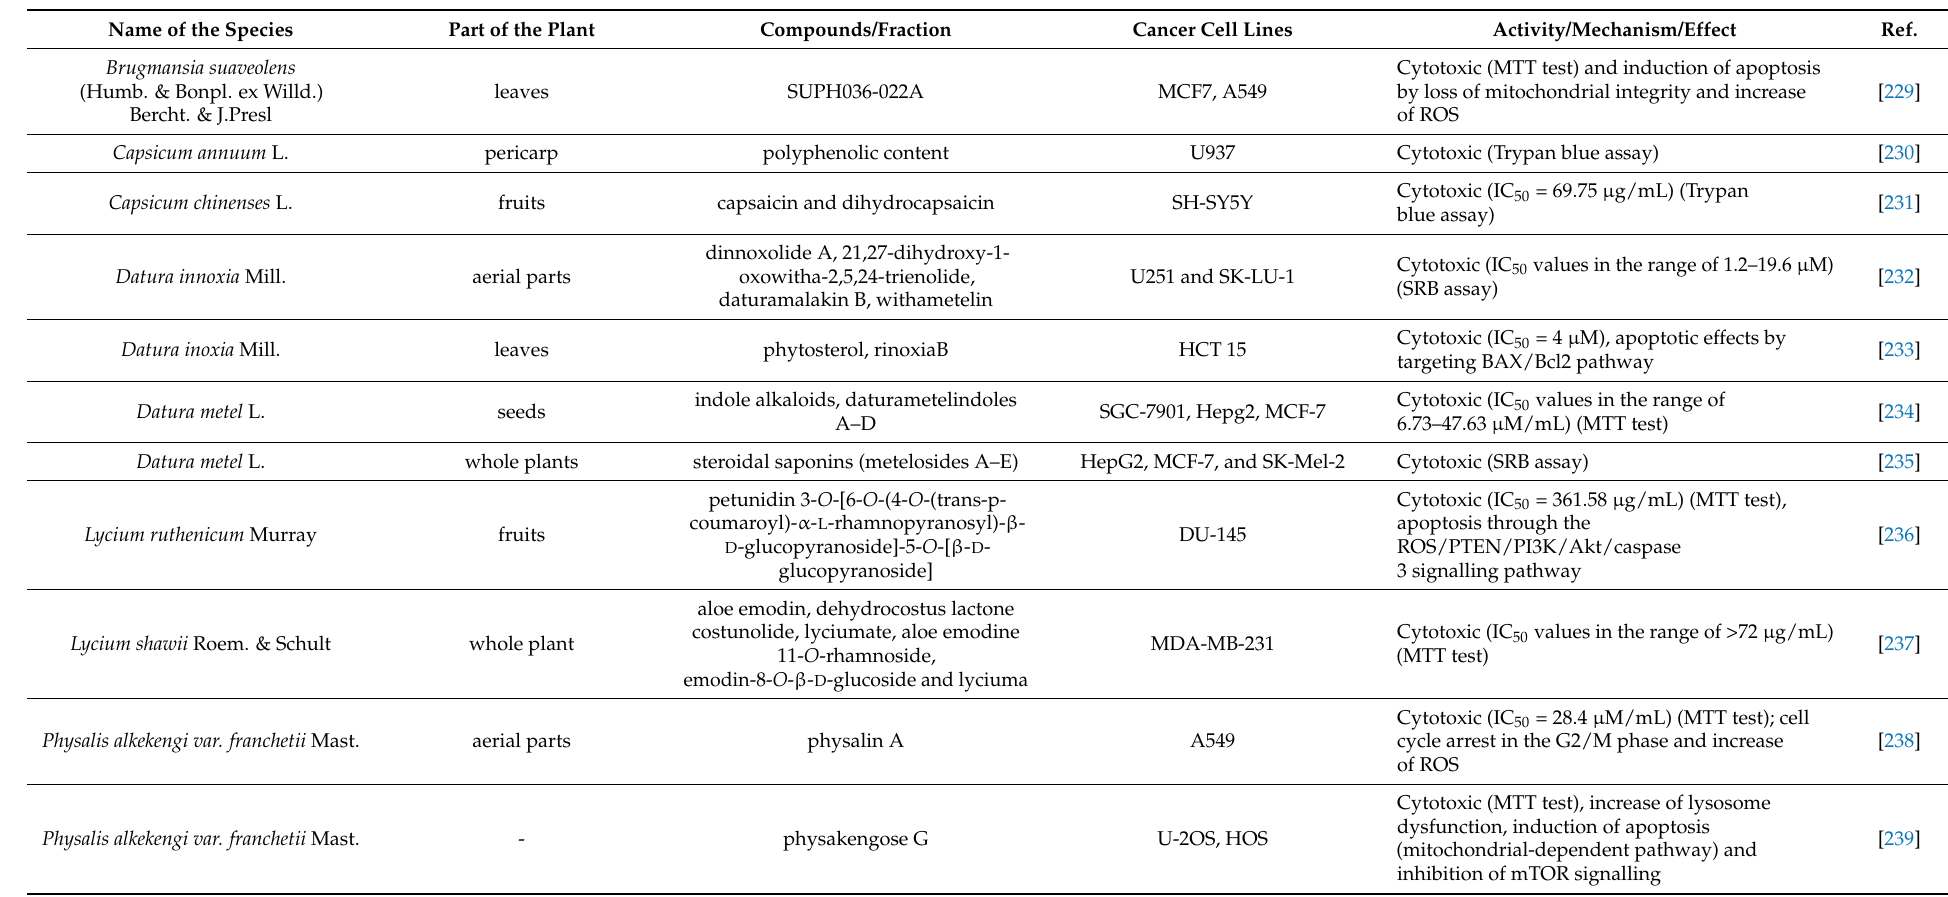
Table 2. In vitro anticancer effect of pure compounds isolated from the Solanaceae family, and their potential mechanisms of action. Name of the